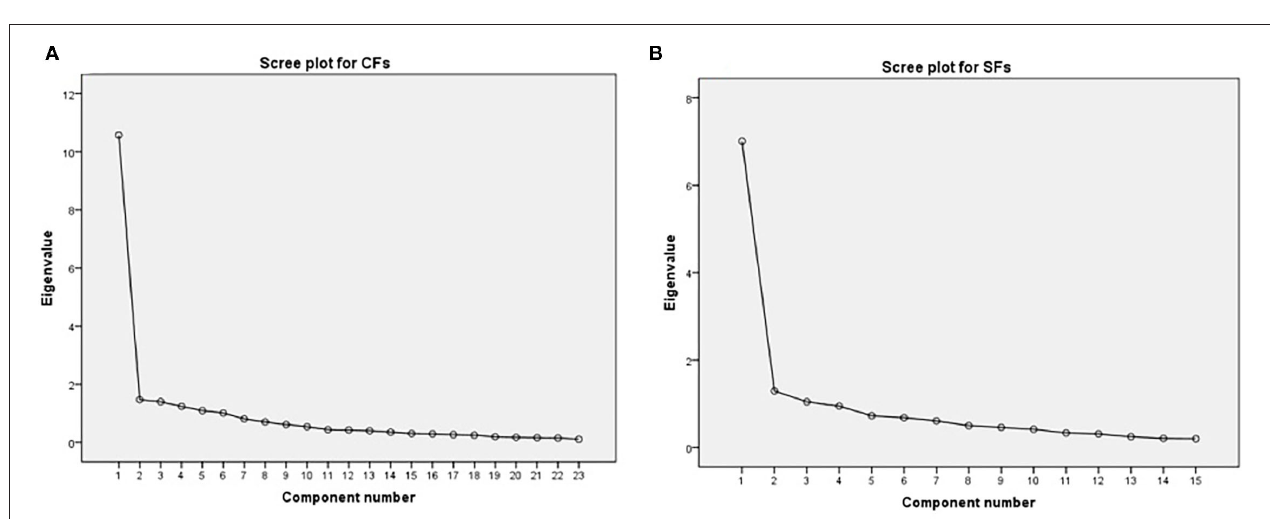
Frontiers in Public Health |